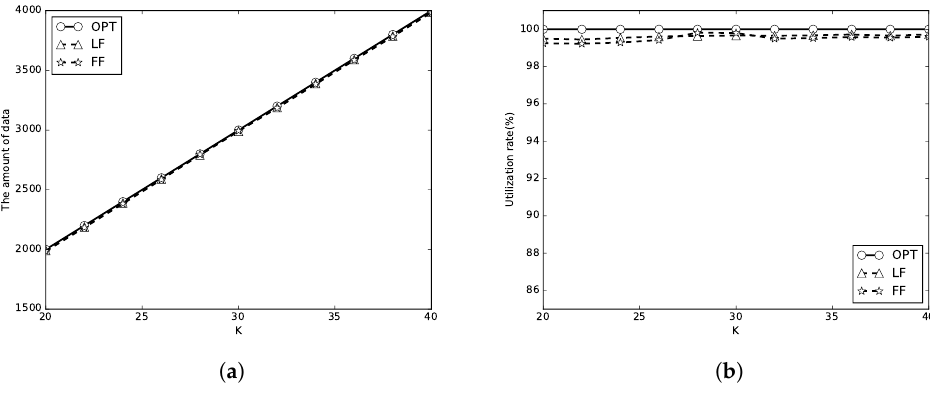
Figure 7. C = 10 E . ( a ) the amount of data; ( b ) energy utilization